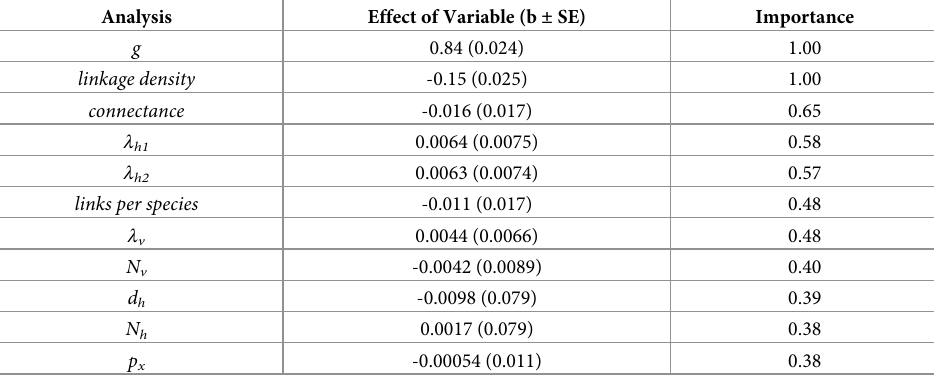
Table 4. Model averaged effects of eight variables on modularity (post-extinction).